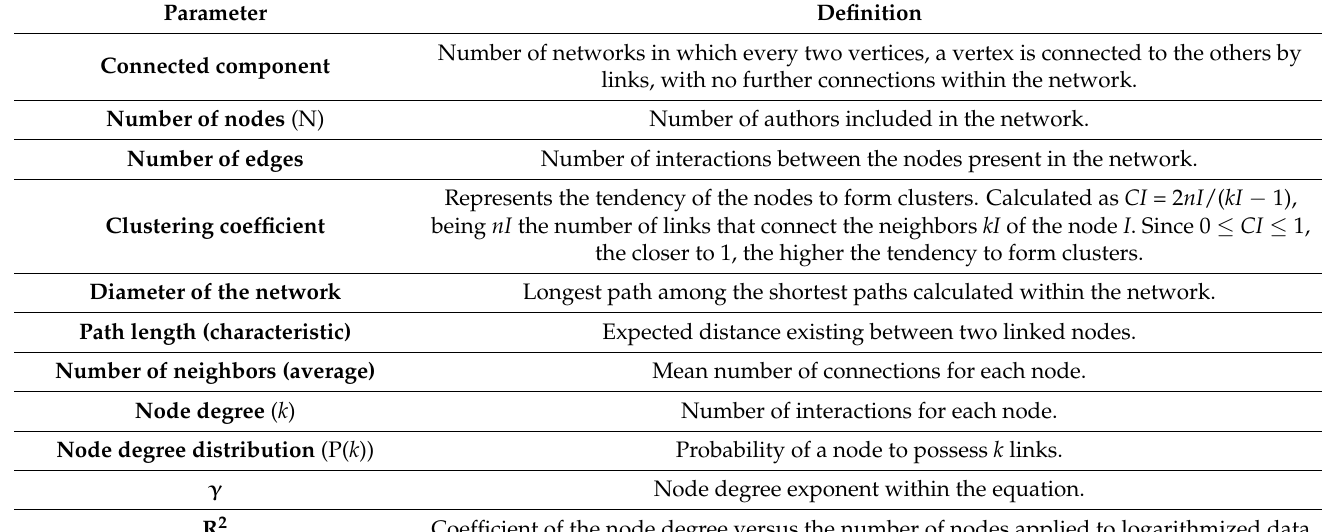
Table 1. Main topological parameters assessed. List of the main topological parameters examined within the network and their definitions.